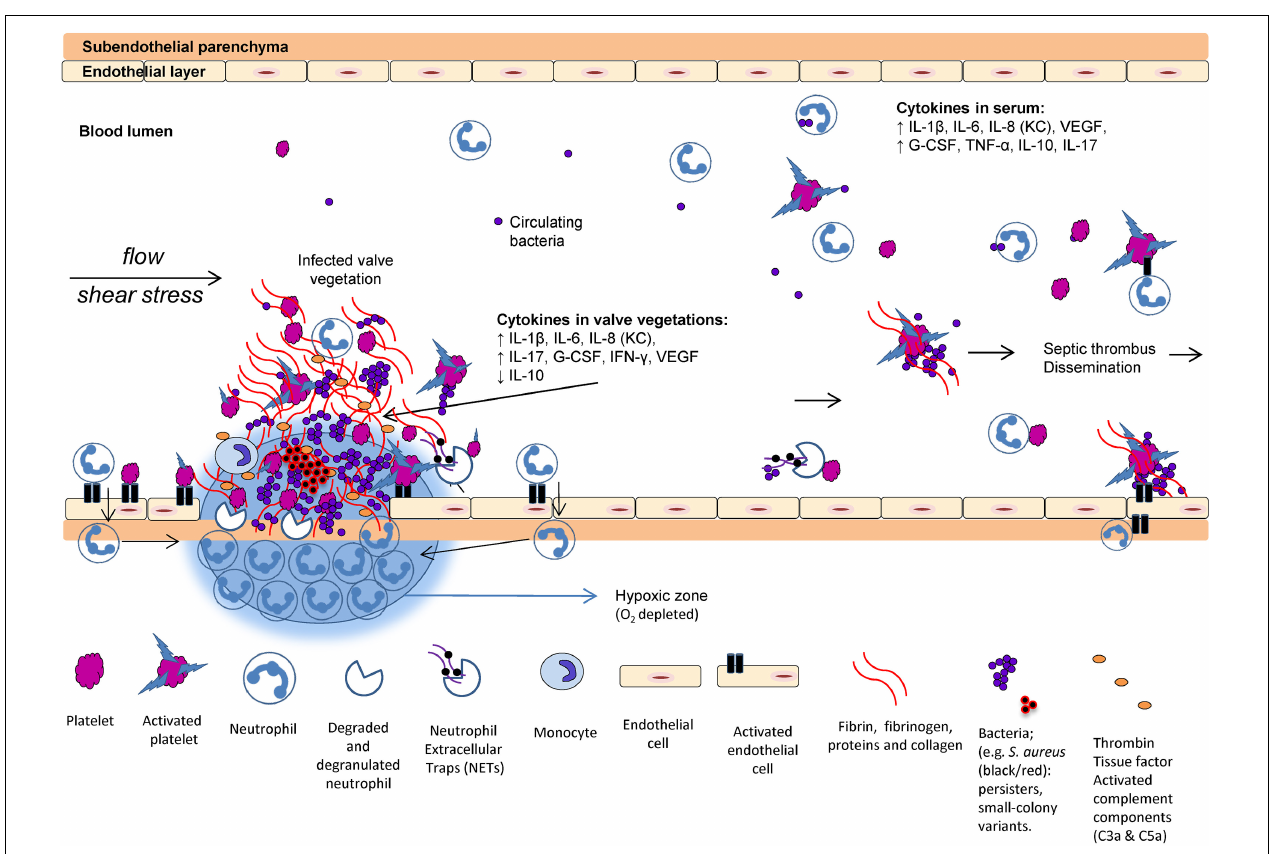
FIGURE 1 | Proposed scenario of interaction between the host and pathogens in infective endocarditis (IE). The formation of valve vegetations is induced by the damaged and infected endothelium. Platelets aggregate to the injured endothelial cells followed by accumulation of innate immune cells and upregulation of tissue factor, fibrinogen, fibrin, and cytokines. O 2 consumption in the valve vegetations (biofilm) and by the activated neutrophils may prevent appropriate O 2 in the tissue. Increased IL-8, interaction between activated platelets and neutrophils trigger the formation of neutrophil extracellular traps (NETs). Many bacteria exhibit virulence mechanisms to survive the NET formation. Deep-seated bacteria are less metabolically active, consequently reducing the efficacy of oxygen-dependent antibiotics. In the local tissue of the valve vegetations, key inflammatory markers of progression are elevated, for example, G-CSF, IL-1 β , IL-6, IL-8 (analog to KC in rodents), IL-17, IFN- γ , and VEGF (Moser et al., 2017) (with permission from the editor of APMIS and